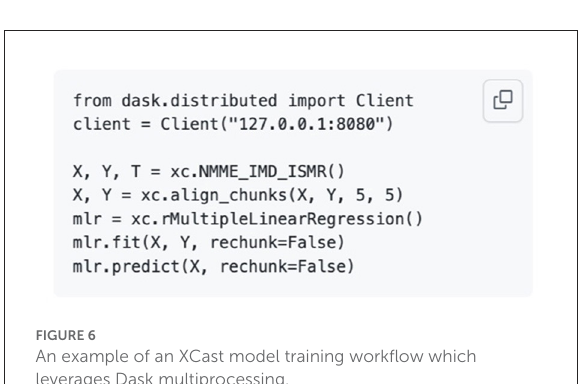
FIGURE6 An example of an XCast model training workflow which leverages Dask